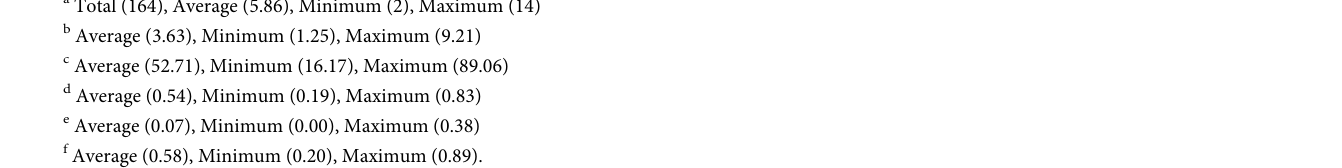
Major allele frequency (%) alleles b